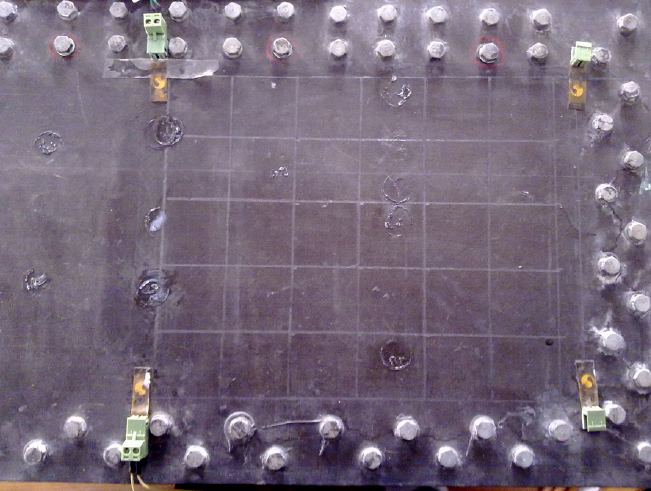
Figure 4. The impact experimental area of the composite laminate on the tank surface.